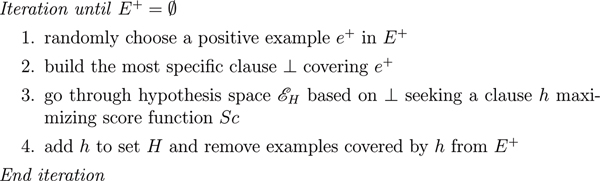
ALEPH Algorithm.